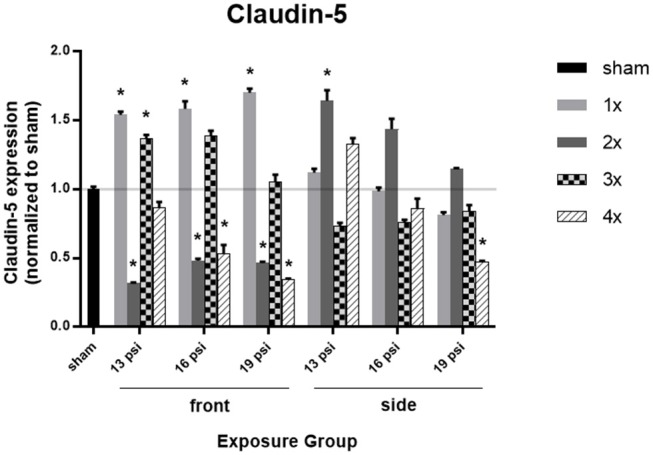
Quantification of claudin-5 expression measured by Western blot. Results presented as blast intensity for each orientation (front vs. side). Values normalized to sham. Statistical significance compared to sham: *p < 0.05 (Significance values in Supplemental Table 3). Data is expressed as mean ± SEM, normalized to sham. Representative Westerns shown in Supplemental Figure 1.